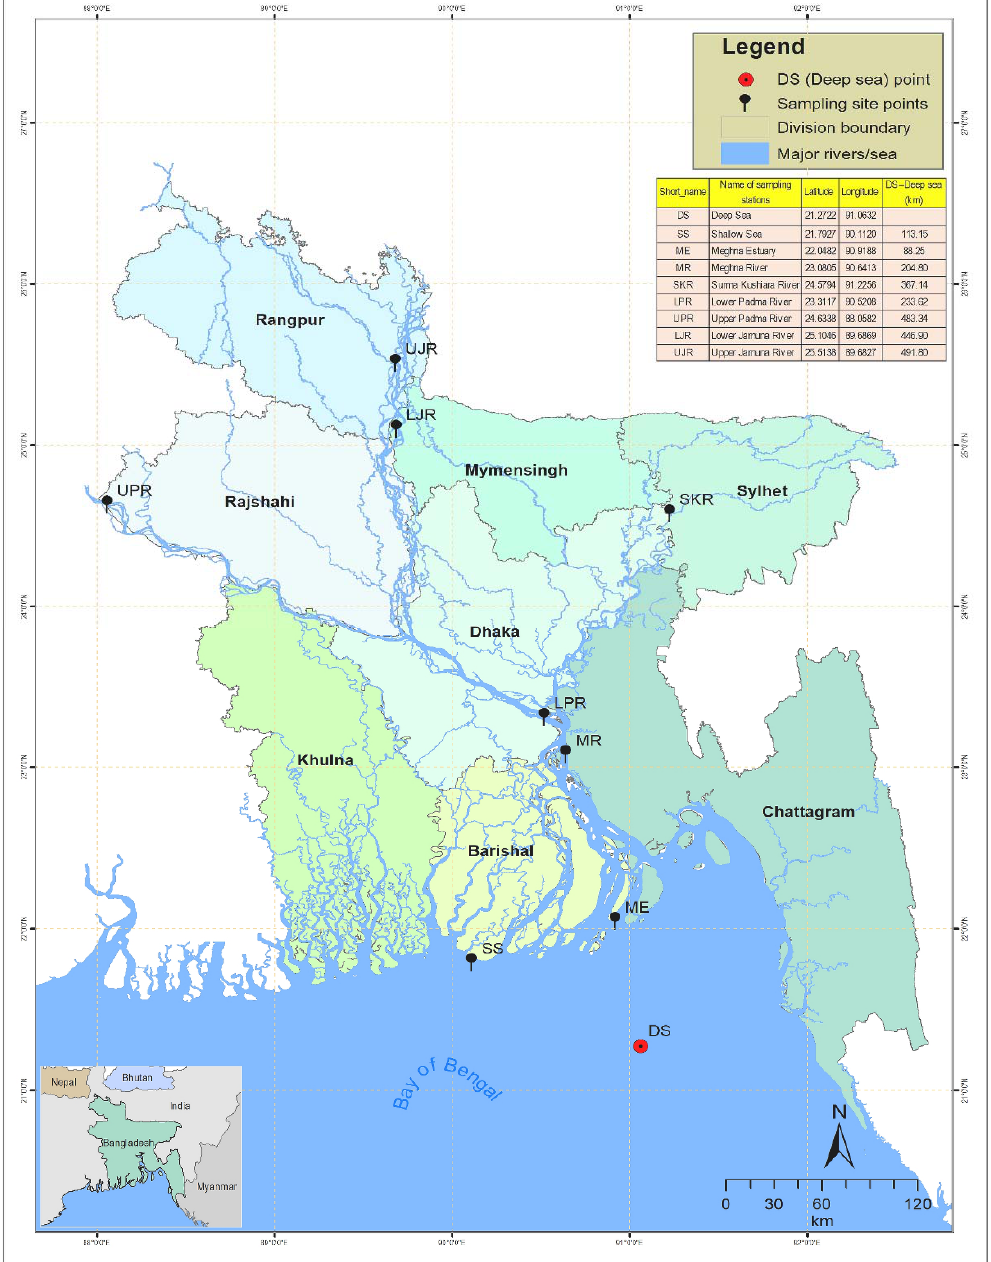
Figure 1. Map of the anadromous Hilsa shad Tenualosa ilisha collections sites across its diverse migratory habitats, including deep sea, shallow sea, estuaries, and different rivers in Bangladesh. DS, deep sea; SS, shallow sea; ME, Meghna estuary; MR, Meghna river; SKR, Surma–Kushiara river; LPR, lower Padma river; UPR, upper Padma river; LJR, lower Jamuna river; UJR, upper Jamuna river.